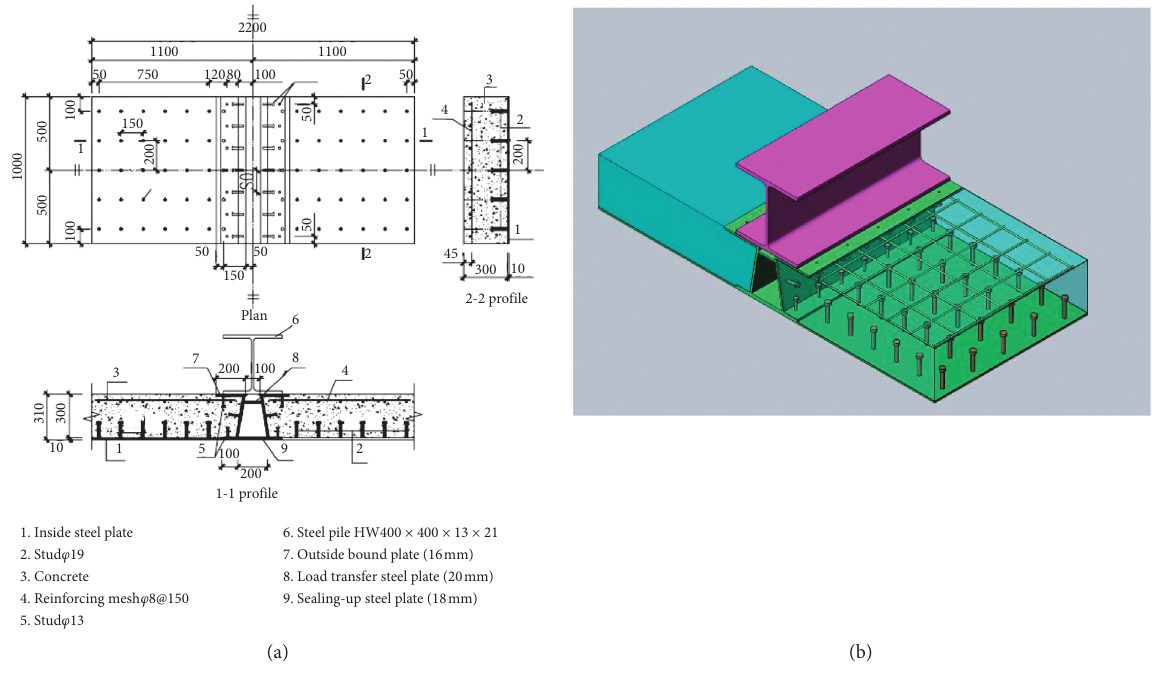
Figure 6: Size and structure of the jointed specimens (unit: